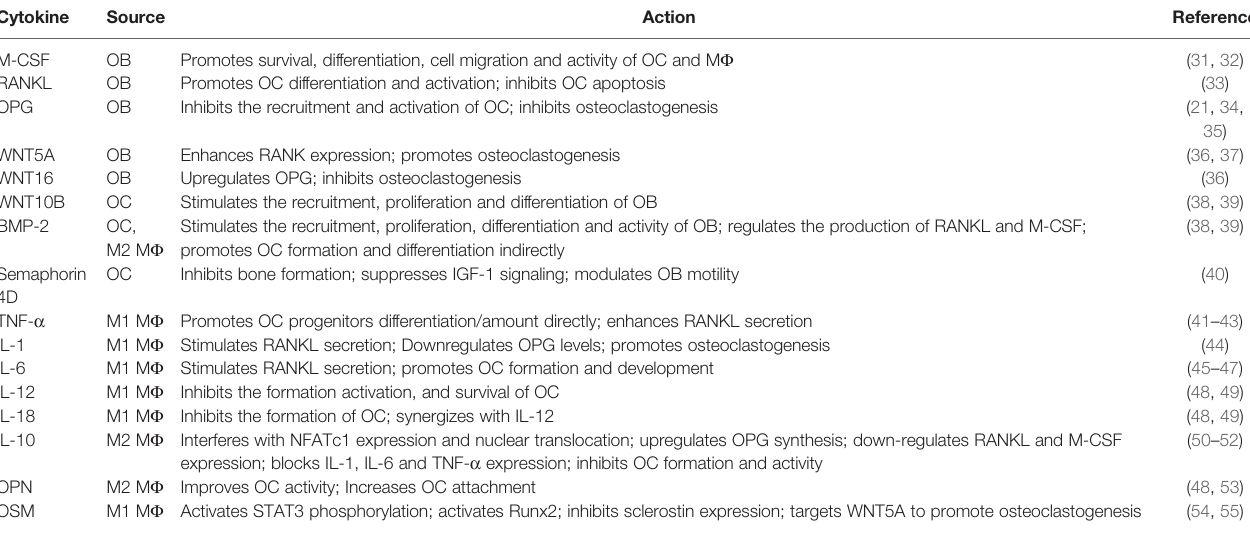
TABLE 1 | Summary of the effects of cytokines in the OB-OC-M F